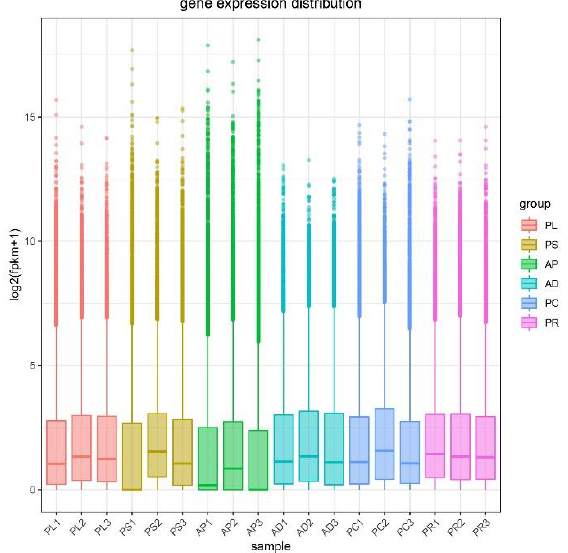
Figure 2. Gene expression distribution boxplot of each sample. The X-coordinate is the sample name, and the Y-coordinate is log2 (FPKM+1). The box plot for each region has 5 statistics (maximum, upper quartile, median, lower quartile, and minimum, respectively). Abbreviations: AD = artificial diet, AP = apples, PR = pears, PL = plums, PC = peaches and PS = peach shoots.